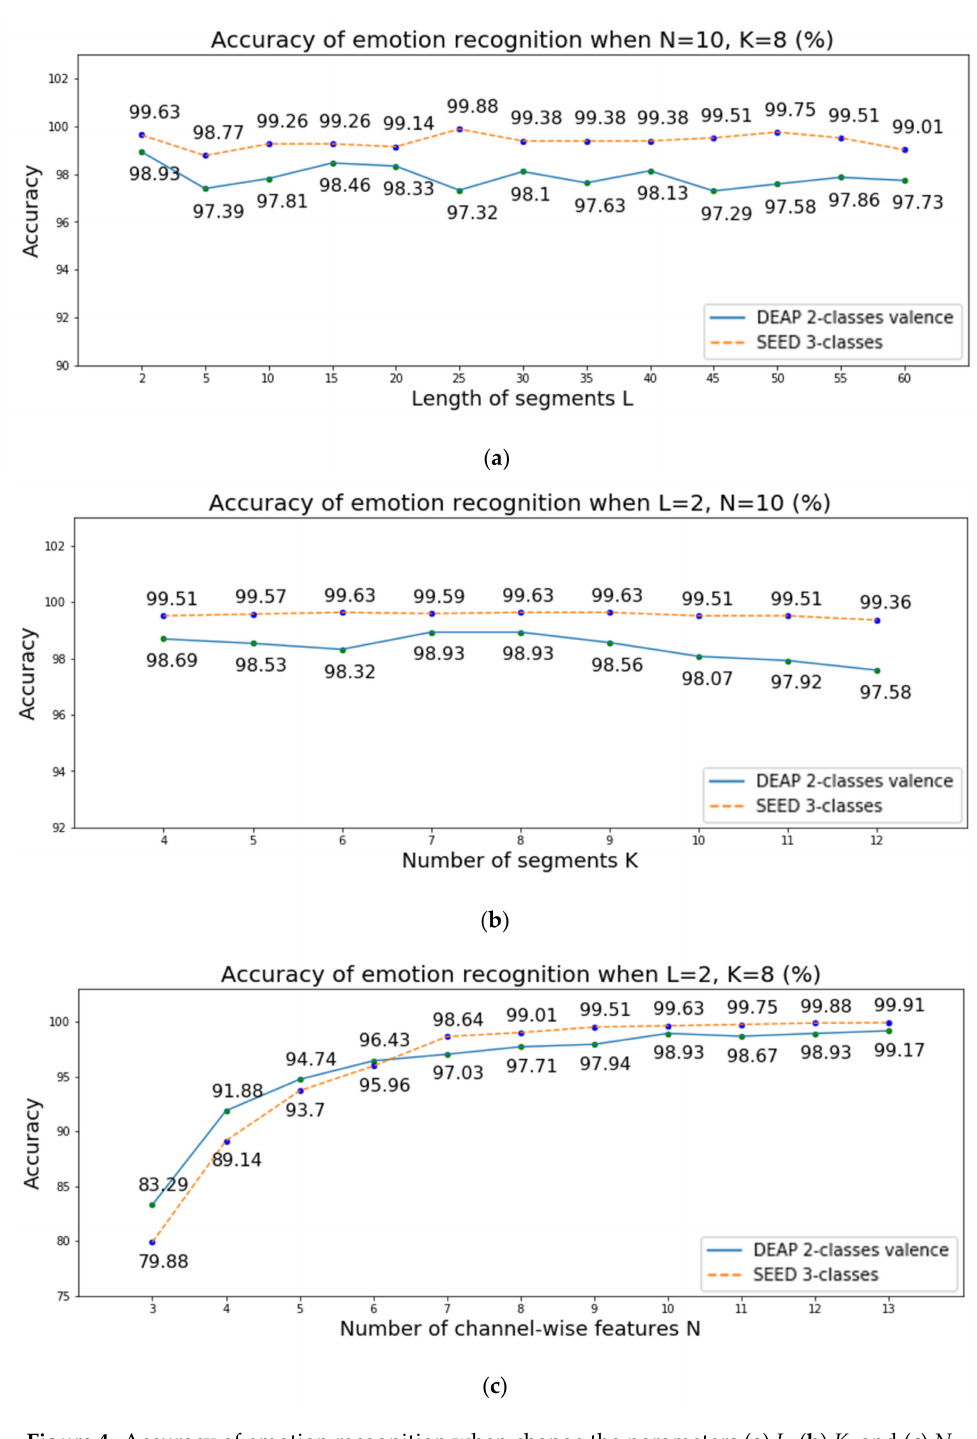
Figure 4. Accuracy of emotion recognition when change the parameters ( a ) L , ( b ) K , and ( c ) N . Thus, in our model, we set the number of data samples in each segment L to 2, the number of segments K to 8 and the number of channel-wise features N to 10 to consider changes of 10 consecutive channel-wise features in the LSTM and classify the emotion accurately. Consequently, our model only requires 2 × 8 × 10 data samples in each EEG channel for emotion recognition. Since the sampling rates R in the DEAP and SEED are 128 Hz and 200 Hz, we only use 1.25 and 0.8 ( L × K × N / R ) second EEG data,